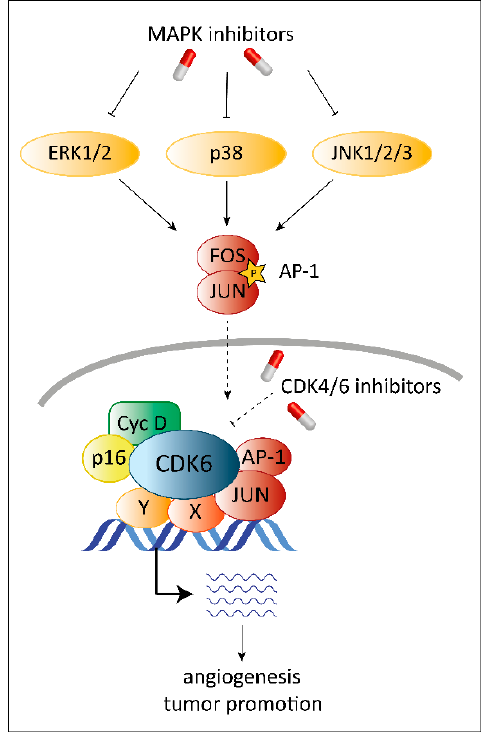
Figure 4. Regulation of transcription mediated by CDK6 and AP-1. CDK6 is not only a cell cycle kinase but also has transcriptional functions. Together with cofactors like JUN (indicated by the star symbol) and potentially also other AP-1 factors it regulates transcription of target genes like VEGF-A [18]. Inhibition of MAPK (indicated by the “T-lines”) blocks activation of AP-1 (indicated by the arrows) and its translocation to the nucleus (indicated by the dashed arrow) and thus might interfere with tumor promoting transcriptional complexes containing CDK6. Blocking of CDK6 with small-molecule inhibitors only inhibits kinase-dependent functions. The transcriptional roles of CDK6 can be dependent or independent of its kinase activity. Thus, treatment with CDK4/6 inhibitors only partially blocks the transcriptional functions of CDK6 (indicated by the dashed “T-line”).